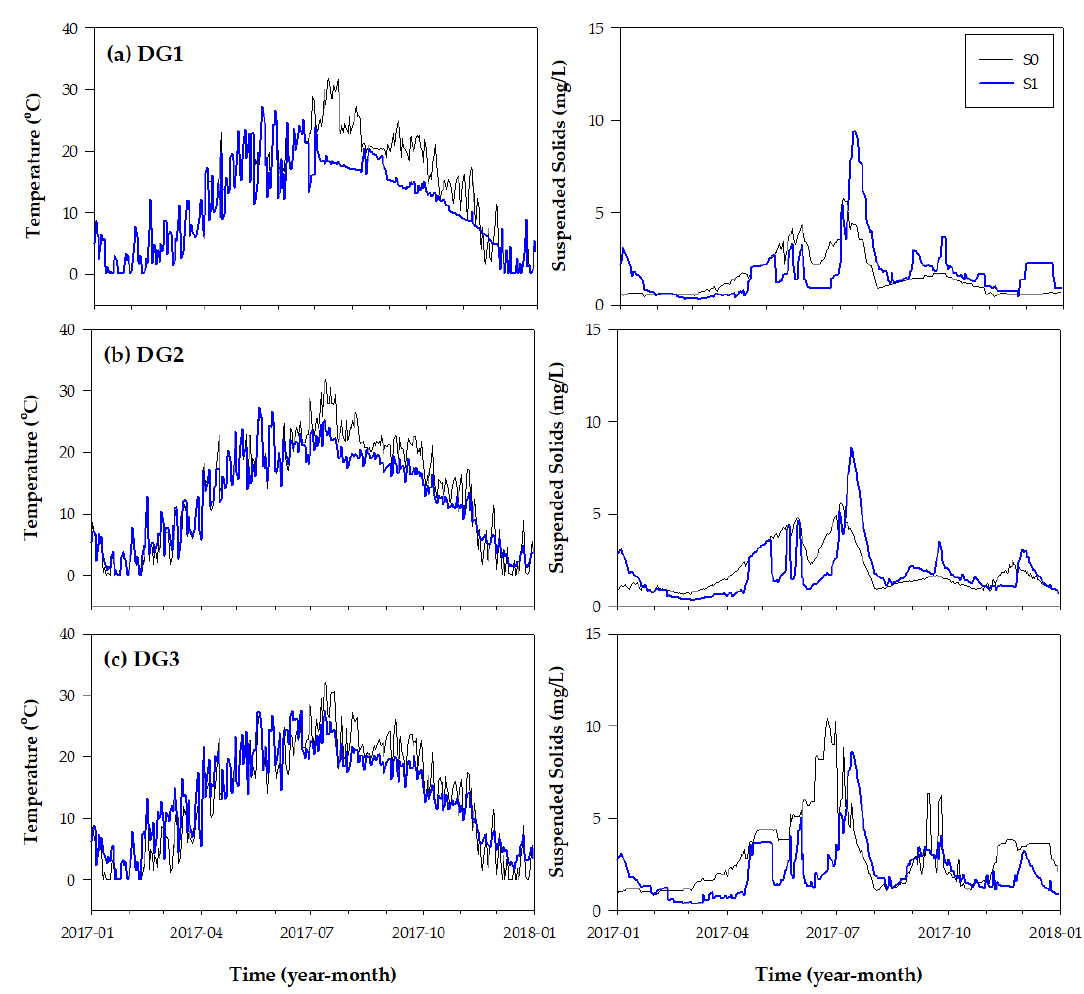
Figure 5. Comparison of the temperature and SS concentration in Kangnung Namdae Stream before and after the discharge of power generation effluents at ( a ) DG1, ( b ) DG2, and ( c ) DG3.